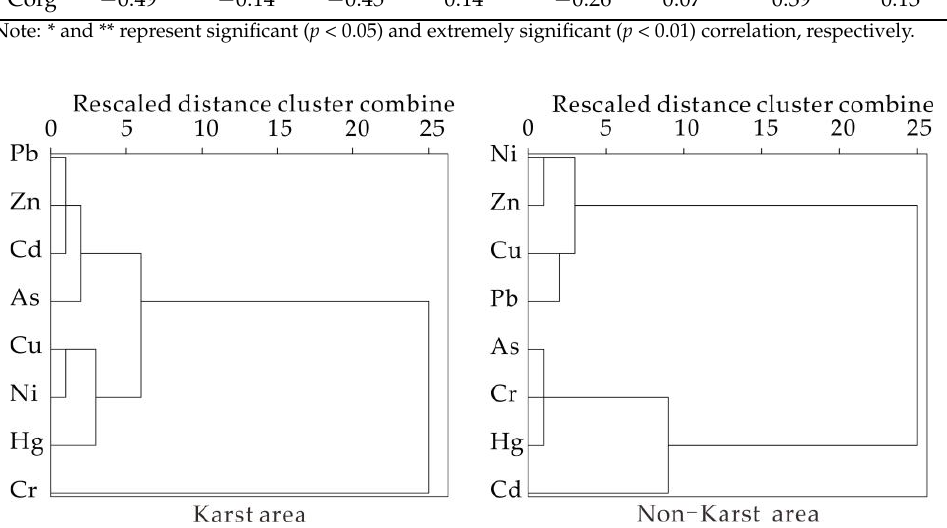
Figure 3. Cluster analysis of soil heavy metals in the study area.